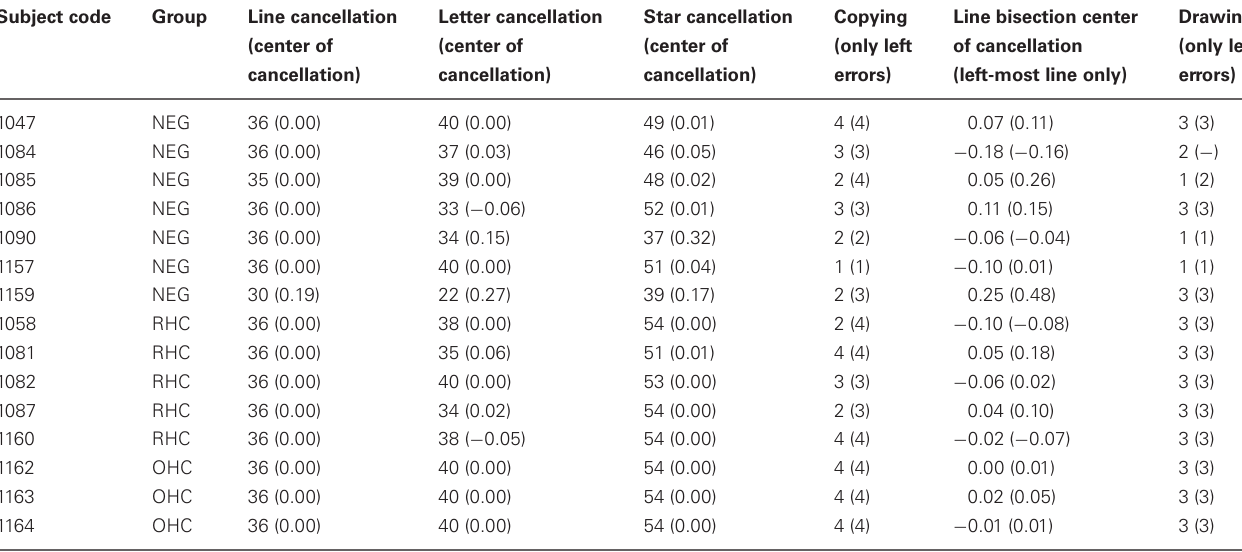
Table A1 | Behavioral inattention task subtest